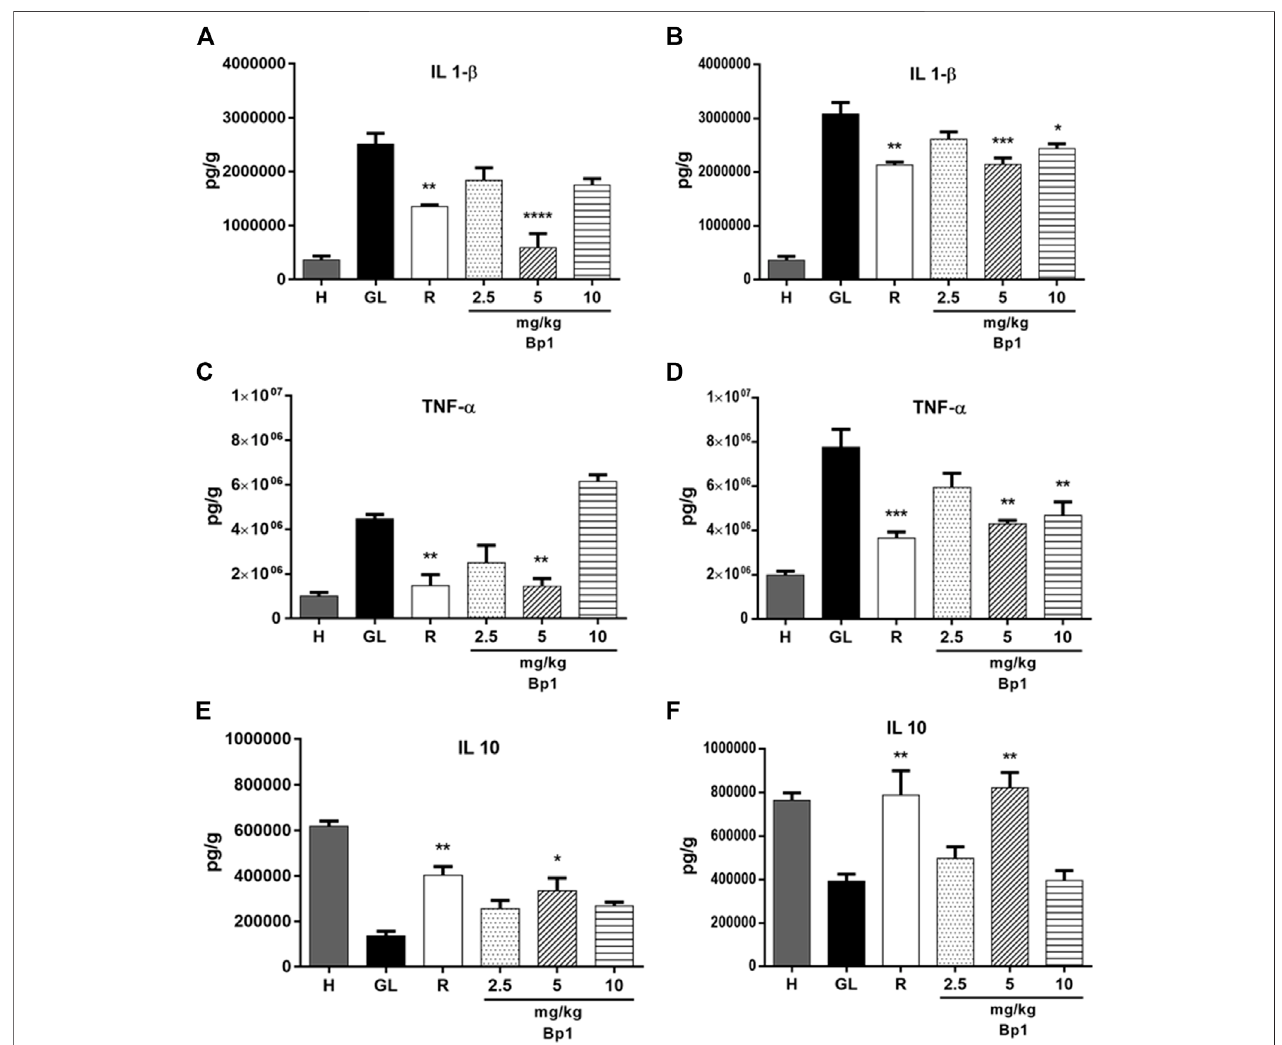
FIGURE 14 | Effect of pretreatment with Bp1 (2.5, 5, and 10 mg/kg) on IL-1 β , TNF- α , and IL-10 levels in the gastric mucosa homogenate of lesions in mice (A – E) ethanol-induced and (B – F) indomethacin-induced. Results expressed as mean ± standard mean error ( n (cid:2) 7). ANOVA and Tukey post-test were used to calculate the statistical signi fi cance, * p < 0.05, ** p < 0.01, *** p < 0.001, and **** p < 0.0001 vs. gastric lesion control. Healthy, H; gastric lesion control, GL; ranitidine (50 mg/kg), R.